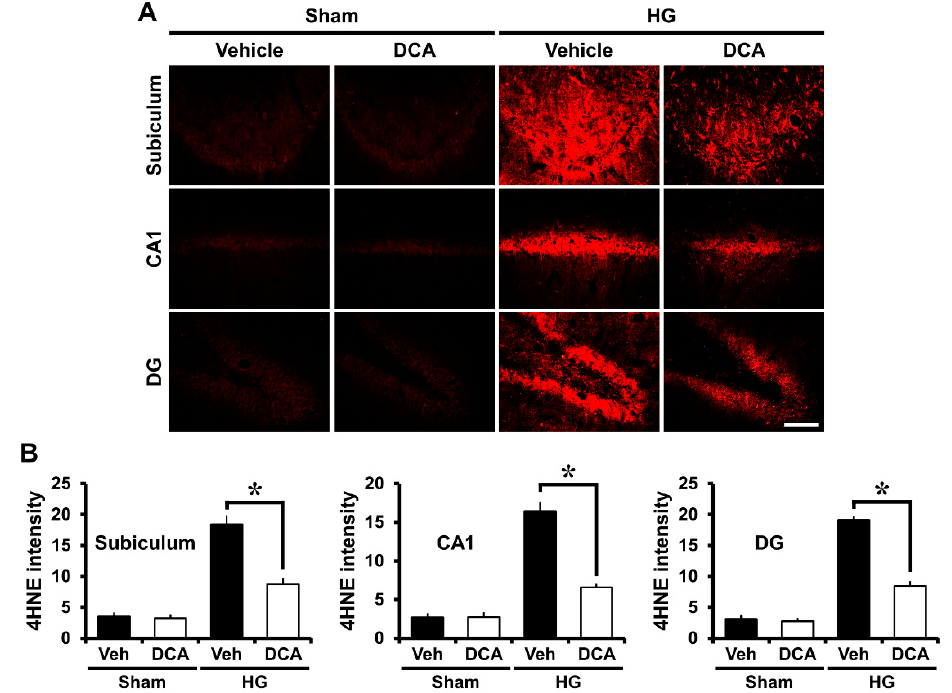
Figure 3. Administration of DCA decreases oxidative injury after hypoglycemia. Neuronal oxidative injury was determined by 4-hydroxy-2-nonenal (4HNE) (red color) staining in the hippocampal regions seven days after hypoglycemia. ( A ) Sham-operated groups rarely displayed the 4HNE signal in the hippocampus. DCA decreased the intensity of 4HNE fluorescence in the hippocampus compared with the saline-treated group after hypoglycemia. Scale bar = 100 µ m. ( B ) 4HNE fluorescence intensity in the hippocampus. The fluorescence intensity indicates a significant gap between saline- and DCA-treated groups. Data are mean ± S.E.M., n = 5 for each sham group. n = 8 for each hypoglycemia group. * Significantly di ff erent from vehicle treated group, p <